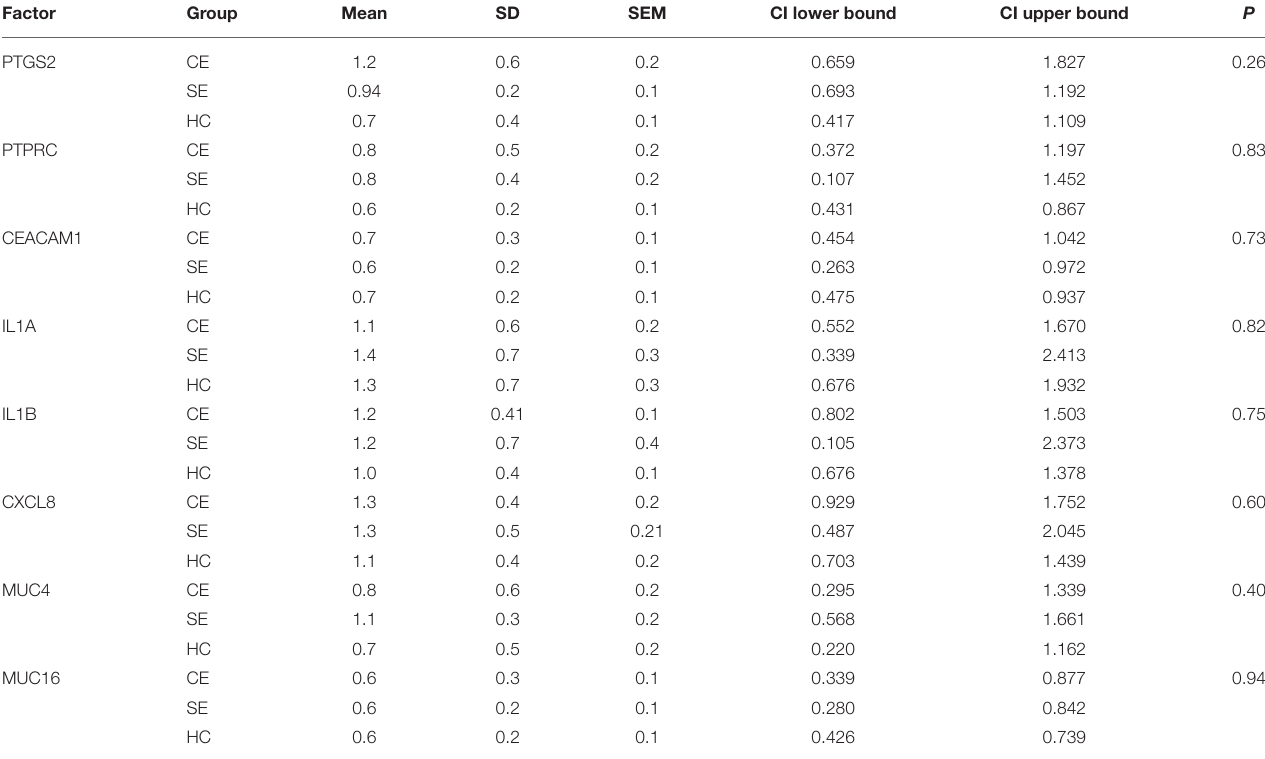
TABLE 4 | Oneway ANOVA of the coefficient of variation (CV) for the normalized mRNA expression of selected transcripts in five pre-defined endometrial sites obtained from seven cows with clinical endometritis (CE), four with subclinical endometritis (SE), and seven healthy control cows (HC) on days 28 to 34 postpartum. Factor Group Mean SD SEM CI lower bound CI upper bound